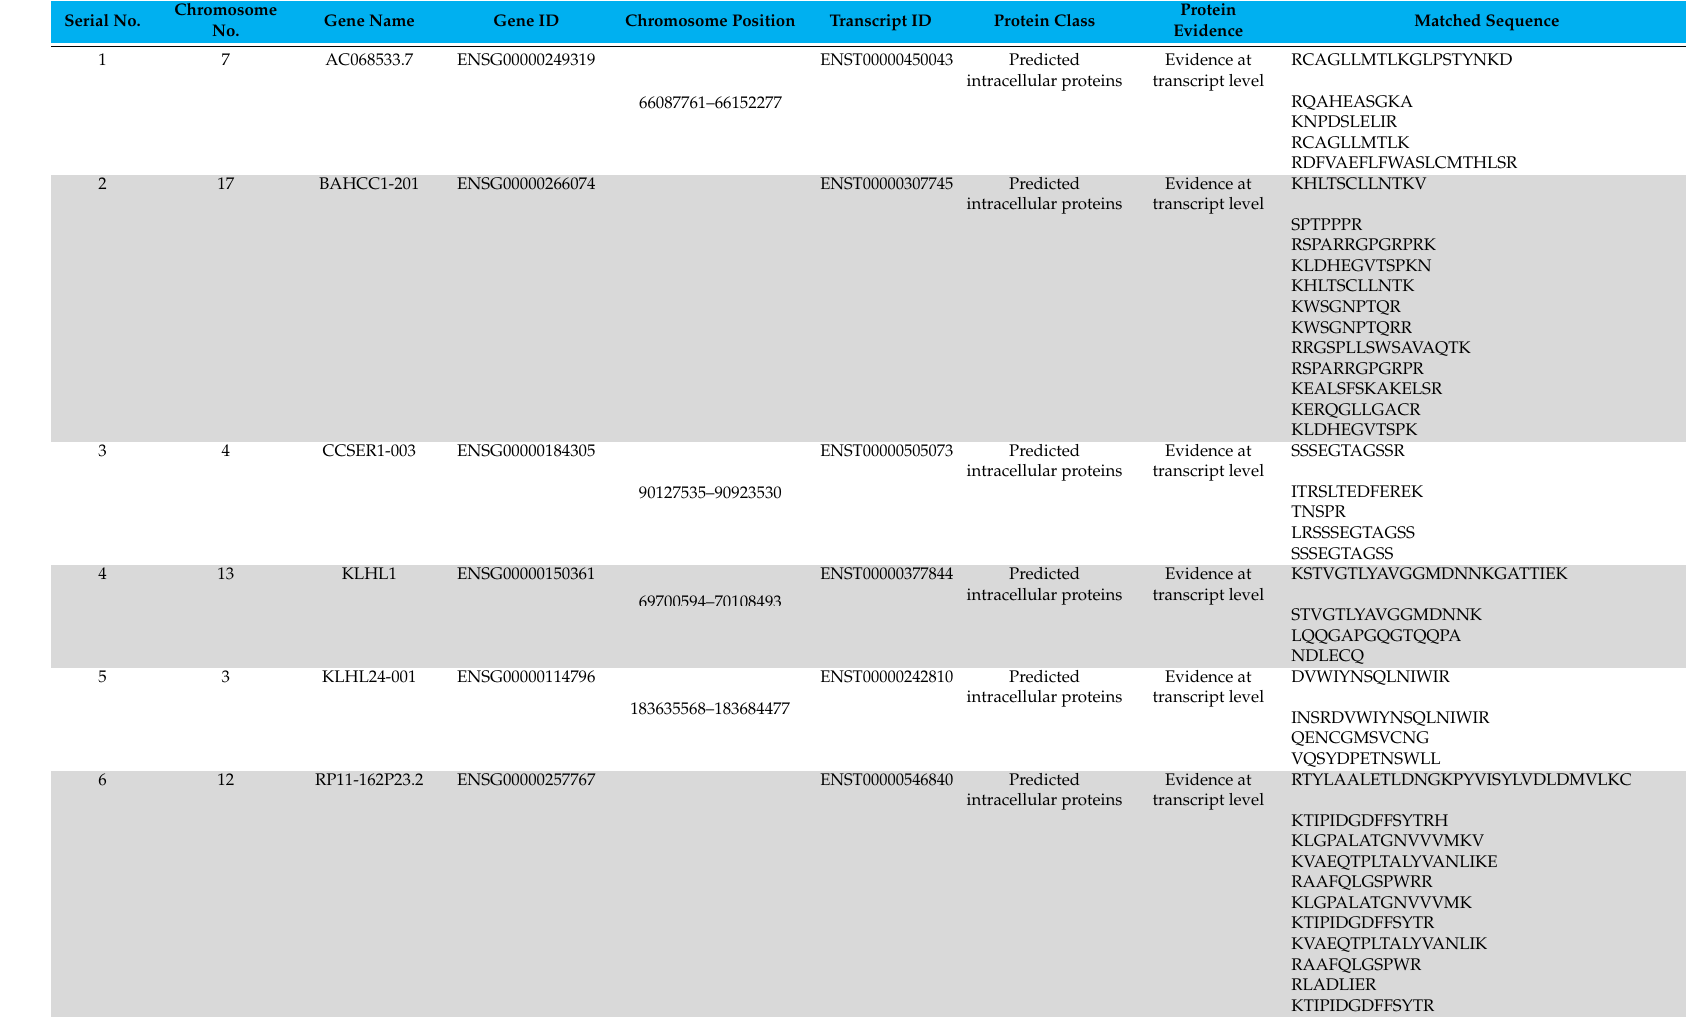
Table 7. Summary of proteins identified by the human protein atlas (HPA)